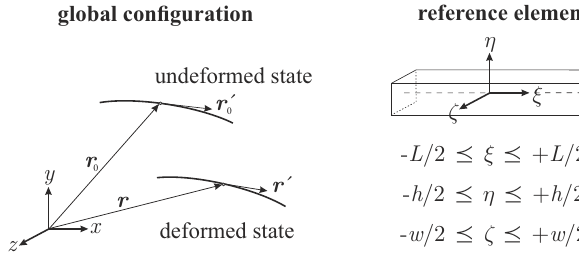
Figure 1. Finite element configurations.